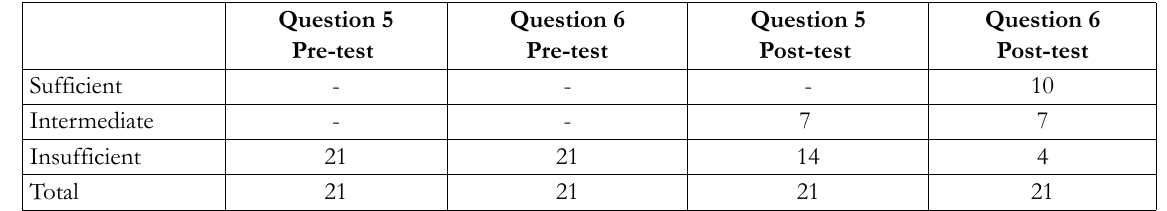
Table 5. The sufficiency of mental representations in responses to questions 5 &